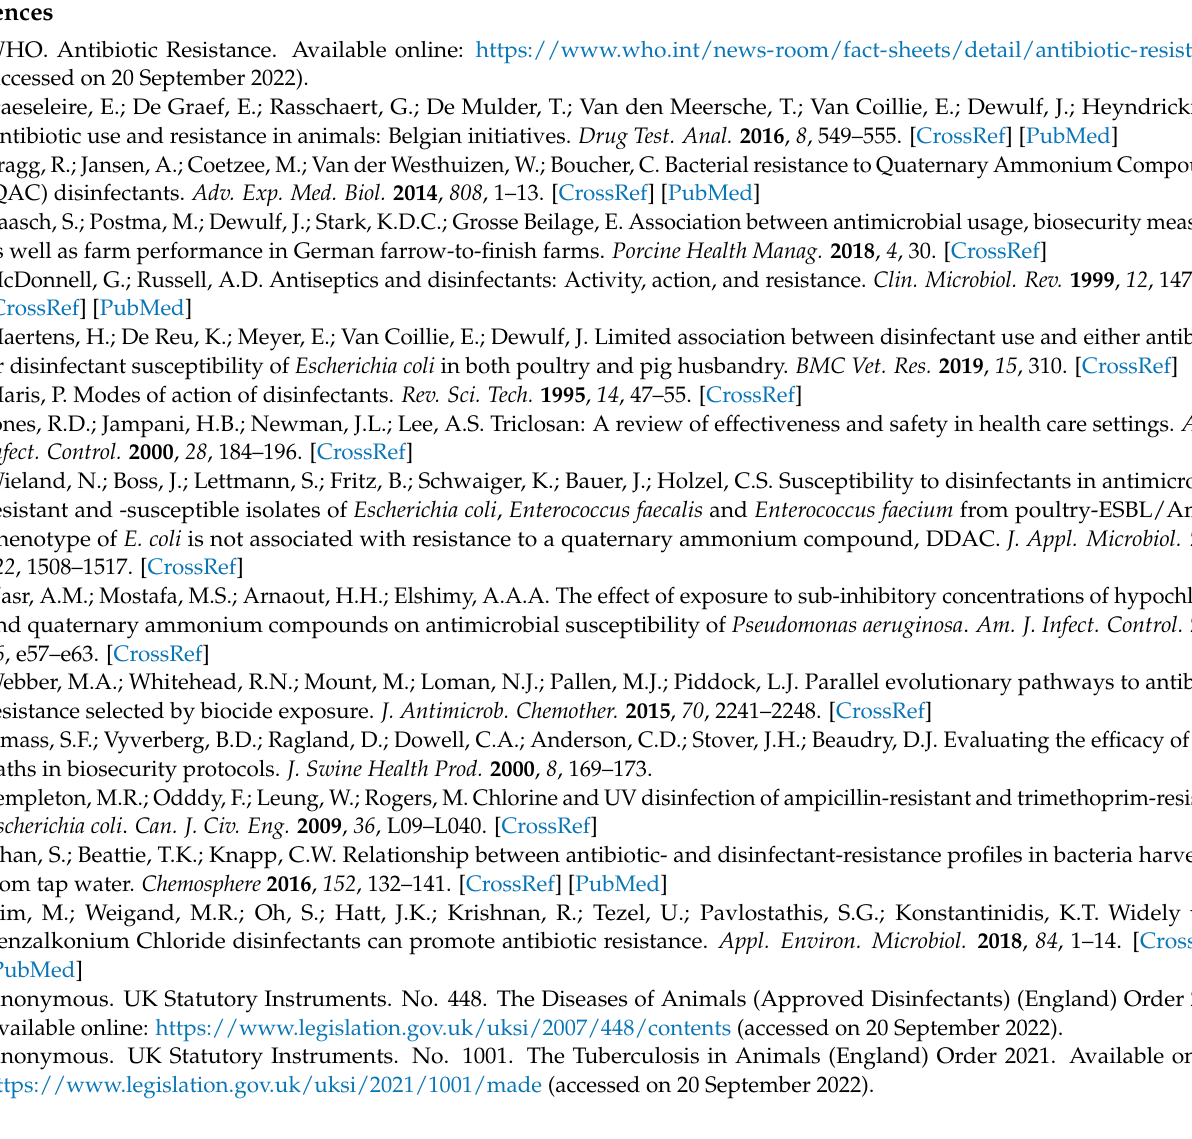
Table S2: Minimum inhibitory concentration (MIC) and minimum bactericidal concentration (MBC) of five disinfectant products against 15 bacterial strains (sorted by bacterial